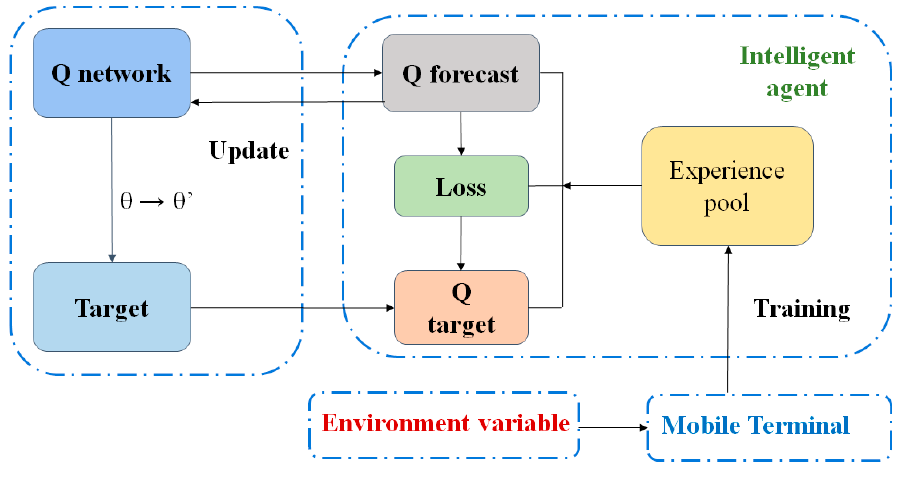
Figure 4. Flowchart of the DQN algorithm.